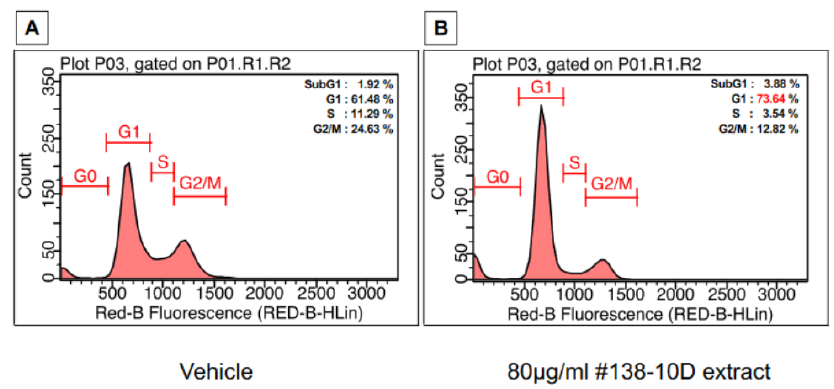
Figure 5. Cell cycle progression analysis. Cells were exposed to the extract at 80 µ g/mL and incubated for 24 h. Cell cycle distribution was determined by a capillary cytometry detection assay. DNA content histograms for treated ( A ) and untreated ( B ) cells show the percentage of cells during SubG1, G1, S and